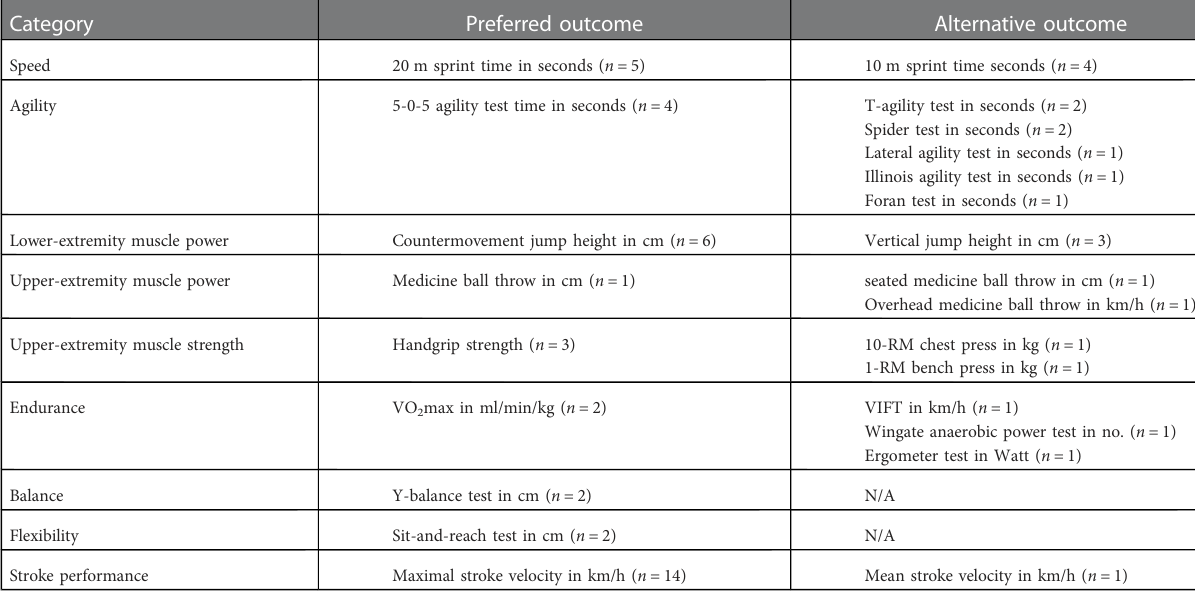
TABLE 2 Overview of the preferred and alternative outcome by category.